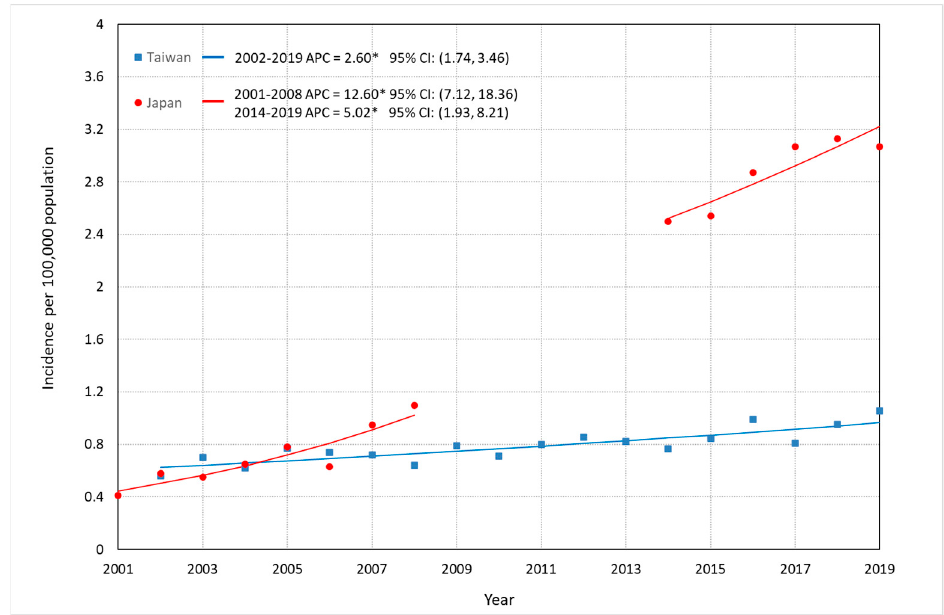
Figure 2. Trends in the ASRs of FL for males in Taiwan and Japan. * The APC is significantly different from 0 at the alpha level of 0.05.